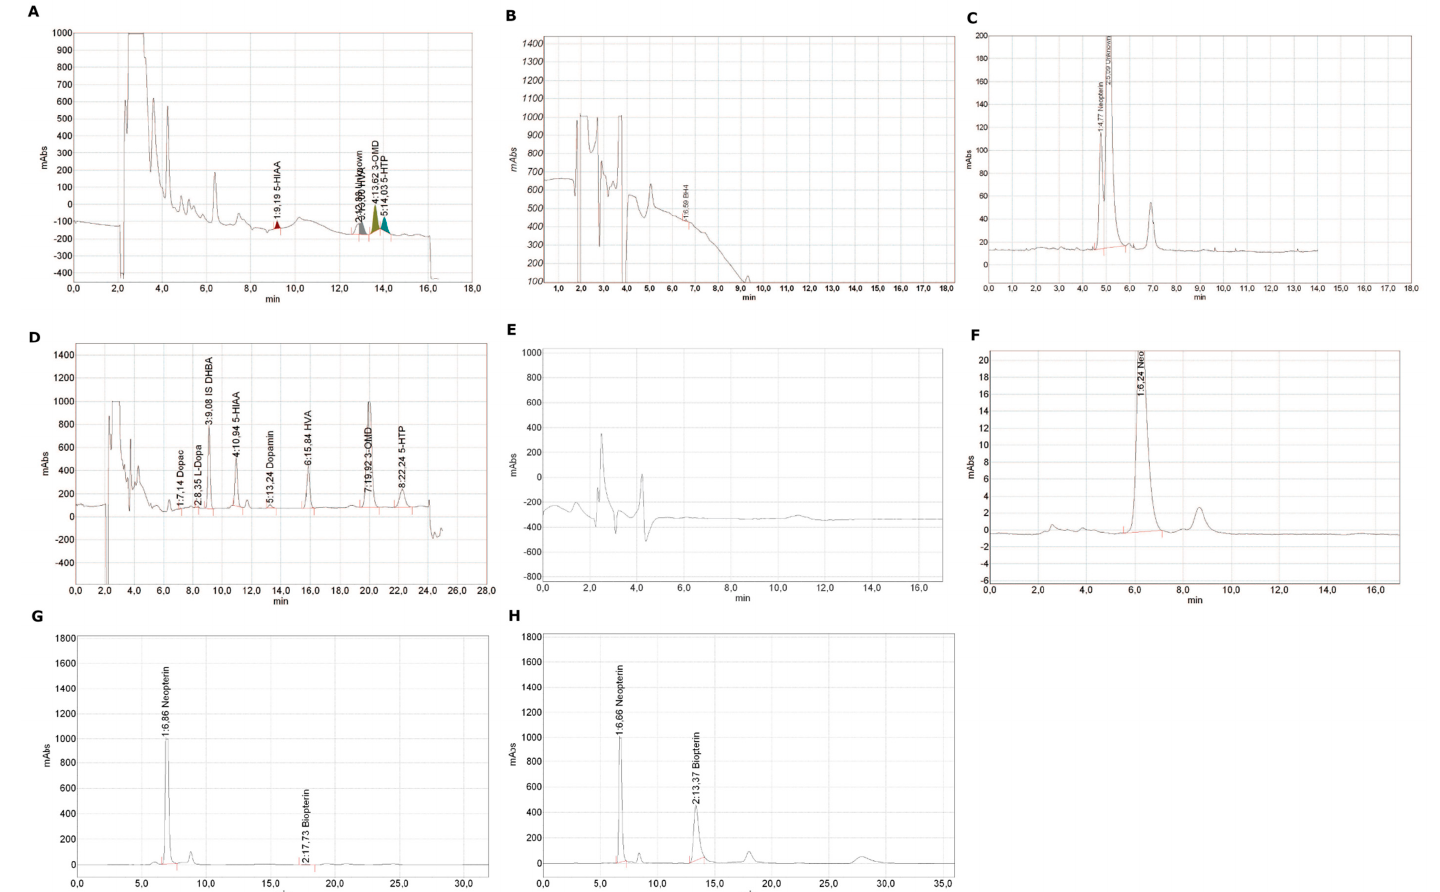
Figure A2. Example chromatograms of a patient su ff ering from PTPS-deficiency. ( A ) The characteristic reduction of both HVA and 5-HIAA in CSF before treatment initiation. ( B ) The characteristic low level of BH 4 before treatment in CSF. ( C ) The high peak for neopterin present in the CSF before treatment. ( D ) The biogenic amines in the CSF of the same patients after treatment initiation. Levels of HVA and 5-HIAA have normalized and dopamine is detectable. ( E ) The BH 4 level in the patient under treatment in CSF. ( F ) The level of neopterin in the CSF under treatment. ( G ) The neopterin level of the patient measured in urine before treatment and ( H ) under treatment. All measurements were performed according to